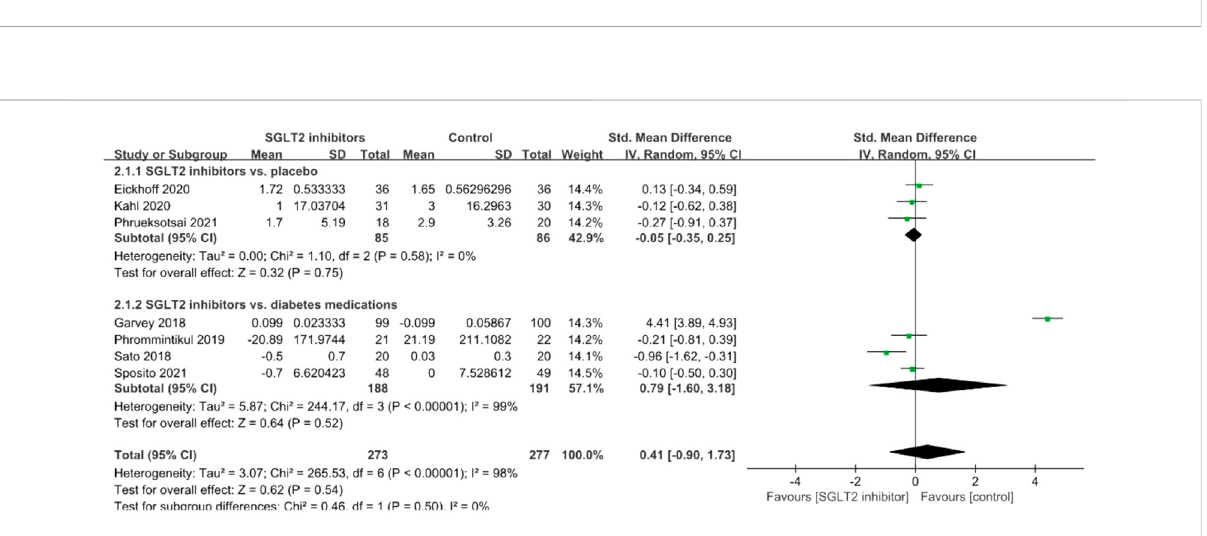
Forest plot of the effects of SGLT2 inhibitors on C-reactive protein.